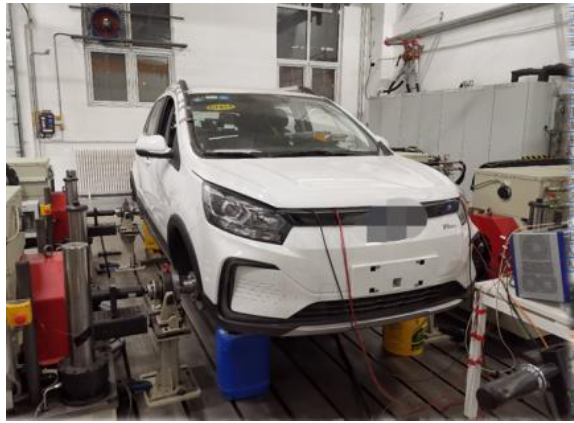
Figure 5. Schematic diagram of the test bench on the vehicle level.